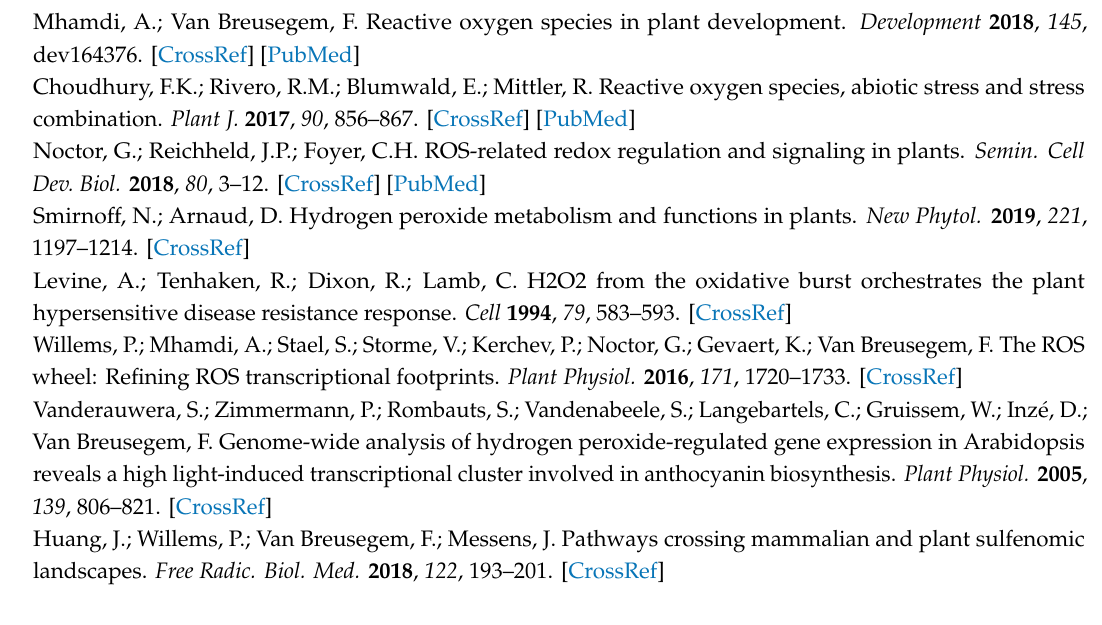
Figure S1. Reversion of photorespiratory-induced F v ’ / F m ’ decline in Nicotiana tabacum cat1 mutants by pakerine; Figure S2. Perturbations showing similarity to pakerine-induced transcriptional changes in wild-type Arabidopsis ; Figure S3. Impaired seed development in aim1-2 cat2-2 double mutant plants; Figure S4. Photorespiratory stress alleviating e ff ect of the chemical probes used for a ffi nity purification; Table S1. Primer sequences used for genotyping of T-DNA insertion lines; Table S2. MaxQuant parameters used for mass spectrometry data analysis; Table S3. Global transcriptome profiling of cat2-2 plants treated with pakerine under control and photorespiratory stress; Table S4. Transcripts that responded to the photorespiratory stress in a pakerine-specific manner according to two-way ANOVA; Table S5. Metabolite profiling of wild-type plants grown in the presence of pakerine; Table S6. Pakerine-induced gene expression in wild-type Arabidopsis ; Table S7. Structure–activity relationship analysis of 34 pakerine analogues; Table S8. List of identified proteins after a ffi nity